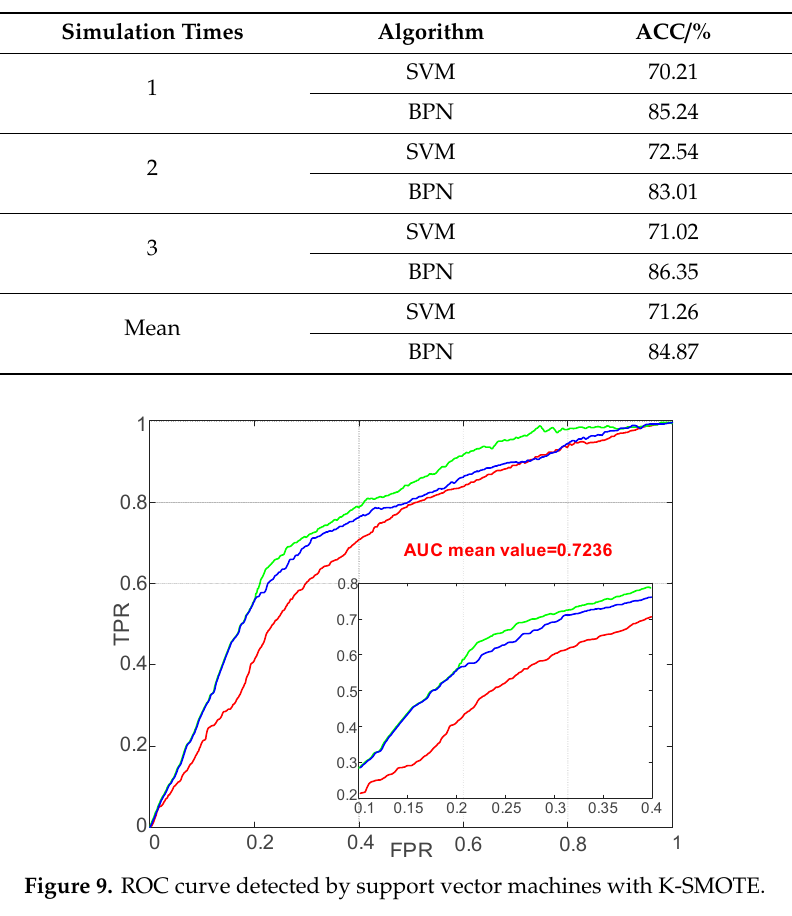
Table 5. Accuracy value of three algorithms.